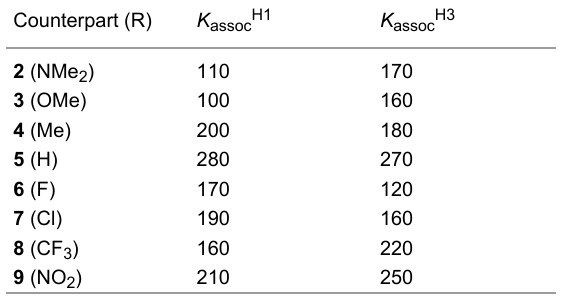
Table 1: Association constants of 1 a [M − 1 ] measured with the use of H1, H3. Counterpart